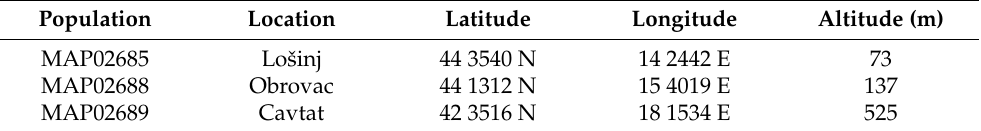
Table 4. Locations from which we obtained seeds of immortelle natural populations from